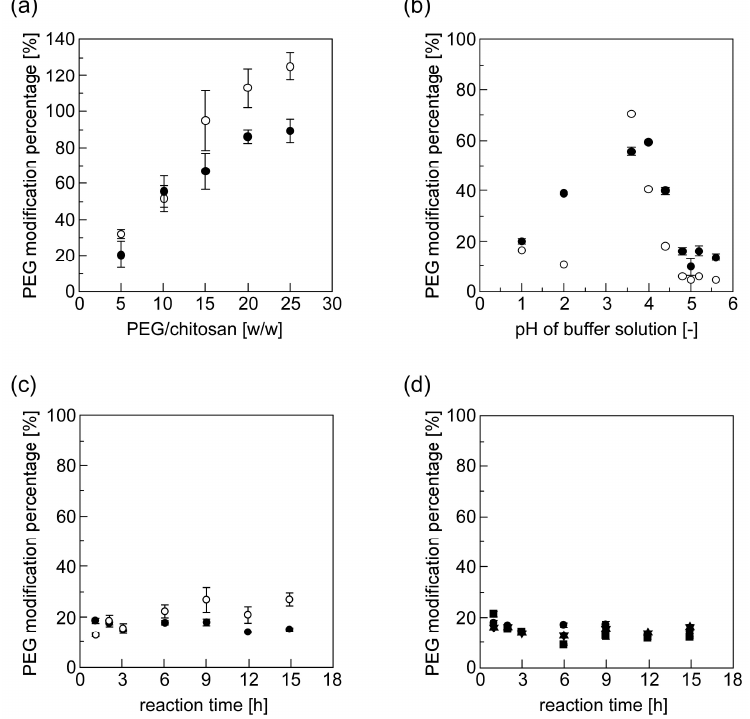
Figure 4. The effect of various factors in the preparation stage of PEG-grafted chitosans on their PMP by means of 1 H NMR measurement (open circle) and TNBS assay (close circle). The factors evaluated were ( a ) the PEG-to-chitosan weight ratio; ( b ) the pH of the buffer solution; ( c ) a reaction time for PEG-chitosan conjugation; and ( d ) a reaction temperature (triangle: 60 °C, square: 37 °C, circle: 25 °C, and reverse triangle: 4 °C; the horizontal axis was the reaction time for the PEG-chitosan conjugation).